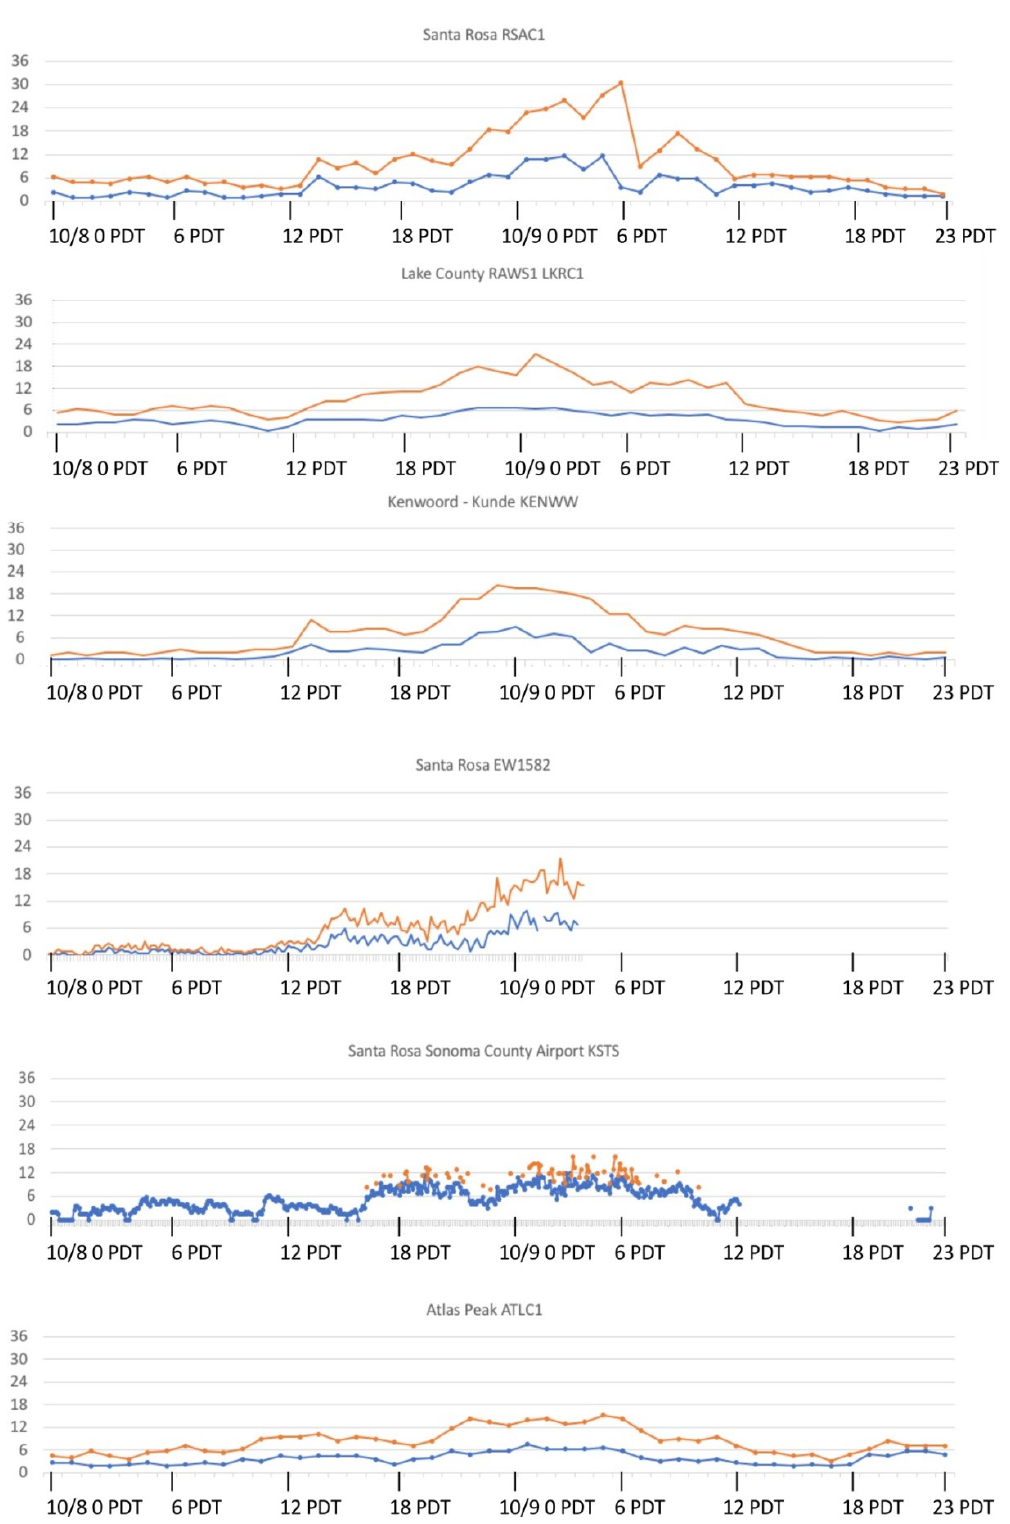
Figure 4. Wind speed (blue) and wind gust (orange) data (in m/s) from surface stations located in Figure 3 that recorded moderate to high wind speeds.